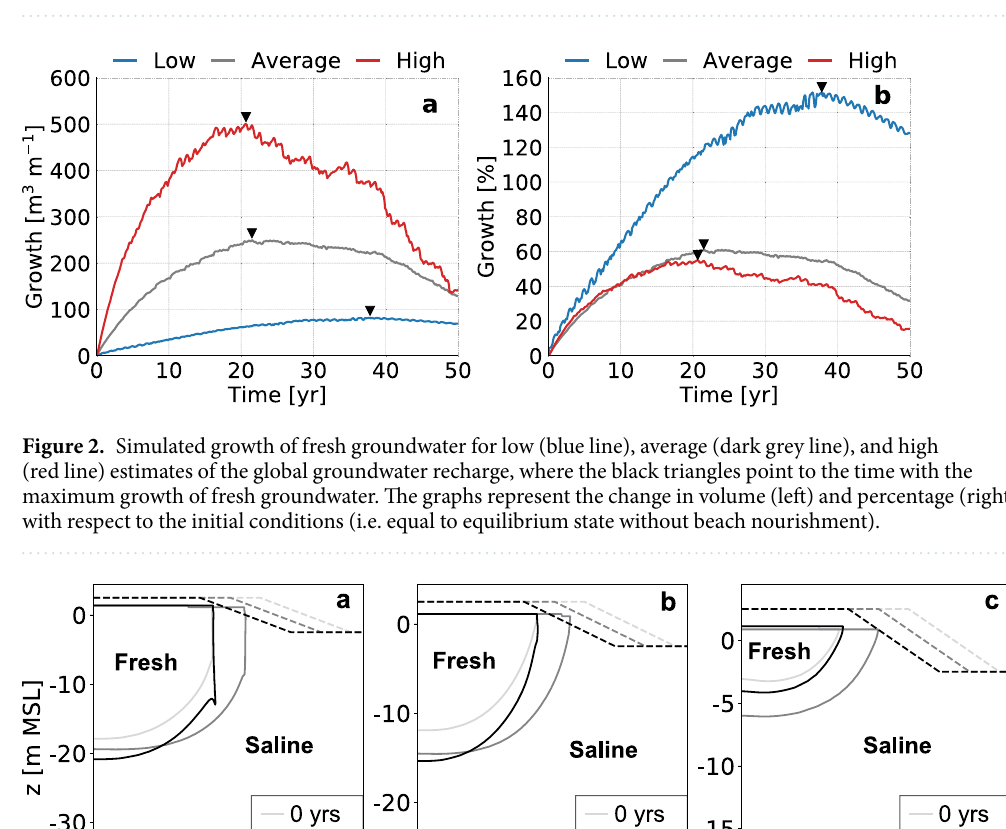
Figure 1. Simulated growth of the fresh groundwater lens for low (left), average (centre), and high (right) groundwater recharge rates. All images contain the fresh-salt groundwater interface of 1 g TDS L − 1 (solid lines) and the surface elevation (dashed lines) at the start (light grey), middle (dark grey) and end (black) of the simulation period.